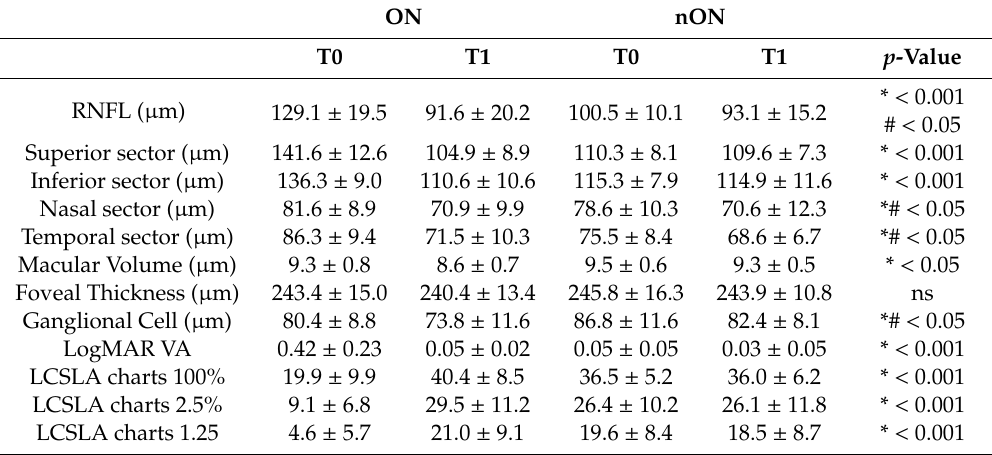
Table 3. Di ff erences in clinical and retinal data a between T0 and T1 in ON and nON eyes. ON